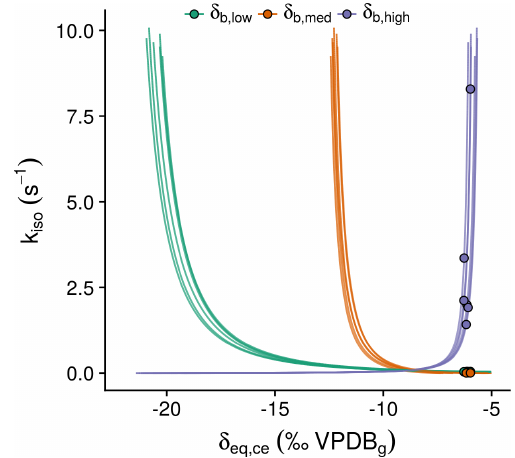
Figure 6. Model relationships between the apparent rate of ex- change ( k iso ) and the δ 18 O of CO 2 in equilibrium with soil wa- ter ( δ eq , ce ). These δ eq , ce values were assumed from the depth- averaged δ 18 O of cryogenically extracted water for the incuba- tions that received the δ iw , low ( δ 18 O of − 6.74 ± 0.03‰ VSMOW– SLAP) irrigation water. Colours indicate the different responses for the same set of incubations at the three inlet conditions that differed by their δ 18 O of CO 2 ( δ b